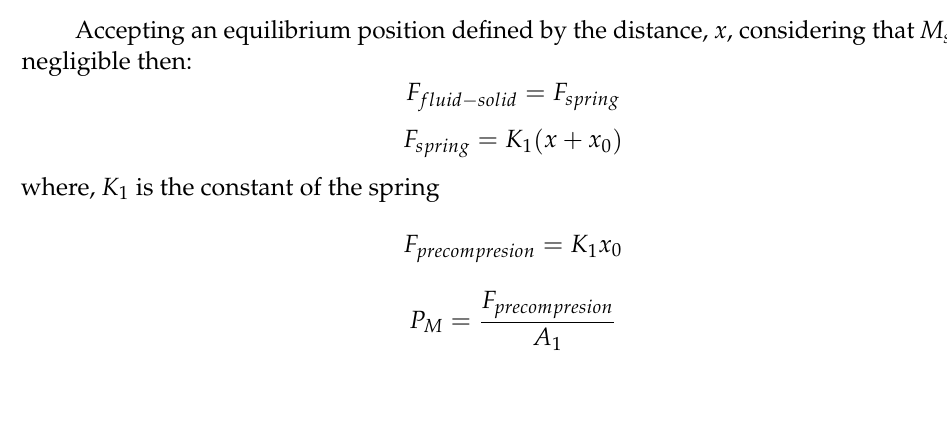
Figure 7. Control volume of the poppet/seat surface system of an LHV valve. Applying Newton’s second law of motion to the valve poppet (considered a free solid) . F fluid − solid − ( F spring + M solid g ) = M solid